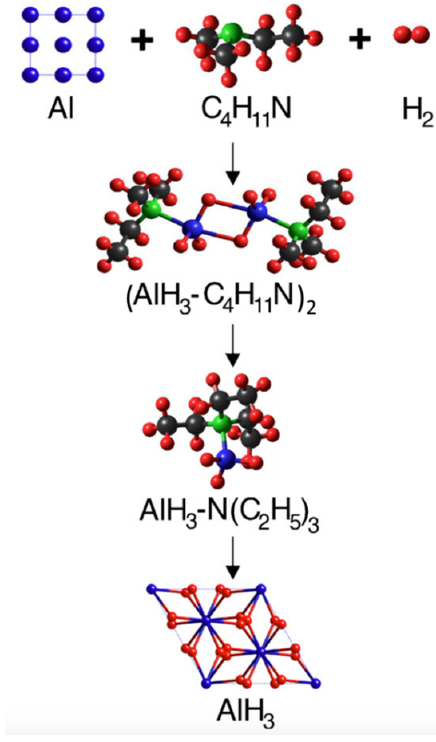
Figure 3. Example of a regeneration pathway for AlH 3 showing hydrogenation of Al and dimethylethylamine (DMEA) to form DMEA-AlH 3 , followed by incorporation of triethylamine (TEA) and transamination to form TEA-AlH 3 , followed by separation to recover AlH 3 . Reproduced from [6]. (Adapted with permission from